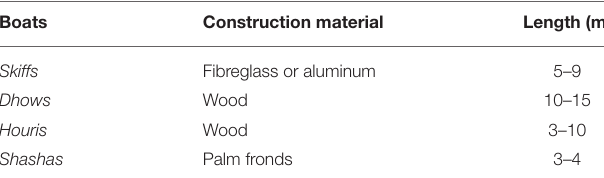
TABLE 1 | Characteristics of Omani artisanal/coastal fishing